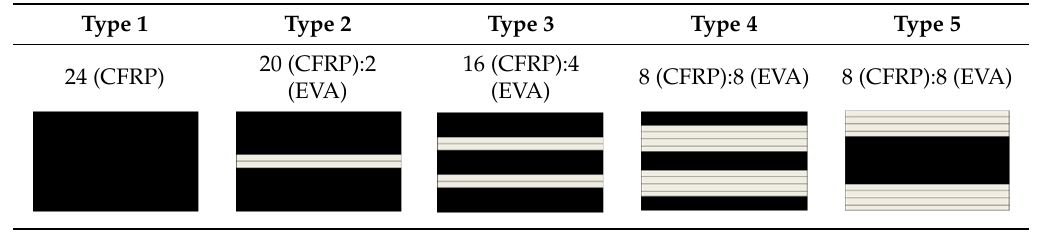
Table 3. Laminated arrangement method. CFRP—carbon-fiber-reinforced plastic.